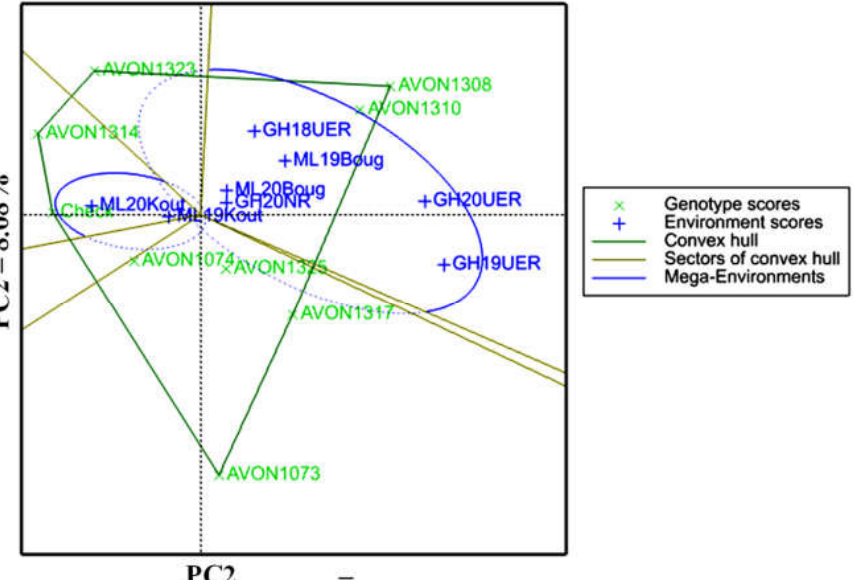
Figure 2. Genotype + G × E interaction (GGE) biplot showing which genotypes performed best in which environment (“which won where”). Dotted vertical and horizontal lines indicate points where the PC1 and PC2 axes had respective values of zero. Vertices of the polygon indicate superior genotypes in each sector. See codes of genotypes in Tables 1 and 4. GH19UER, Upper East Region, 2019; GH20UER, Upper East Region, 2020; GH20NR, Northern Region; ML19Kout, Koutiala 2019;